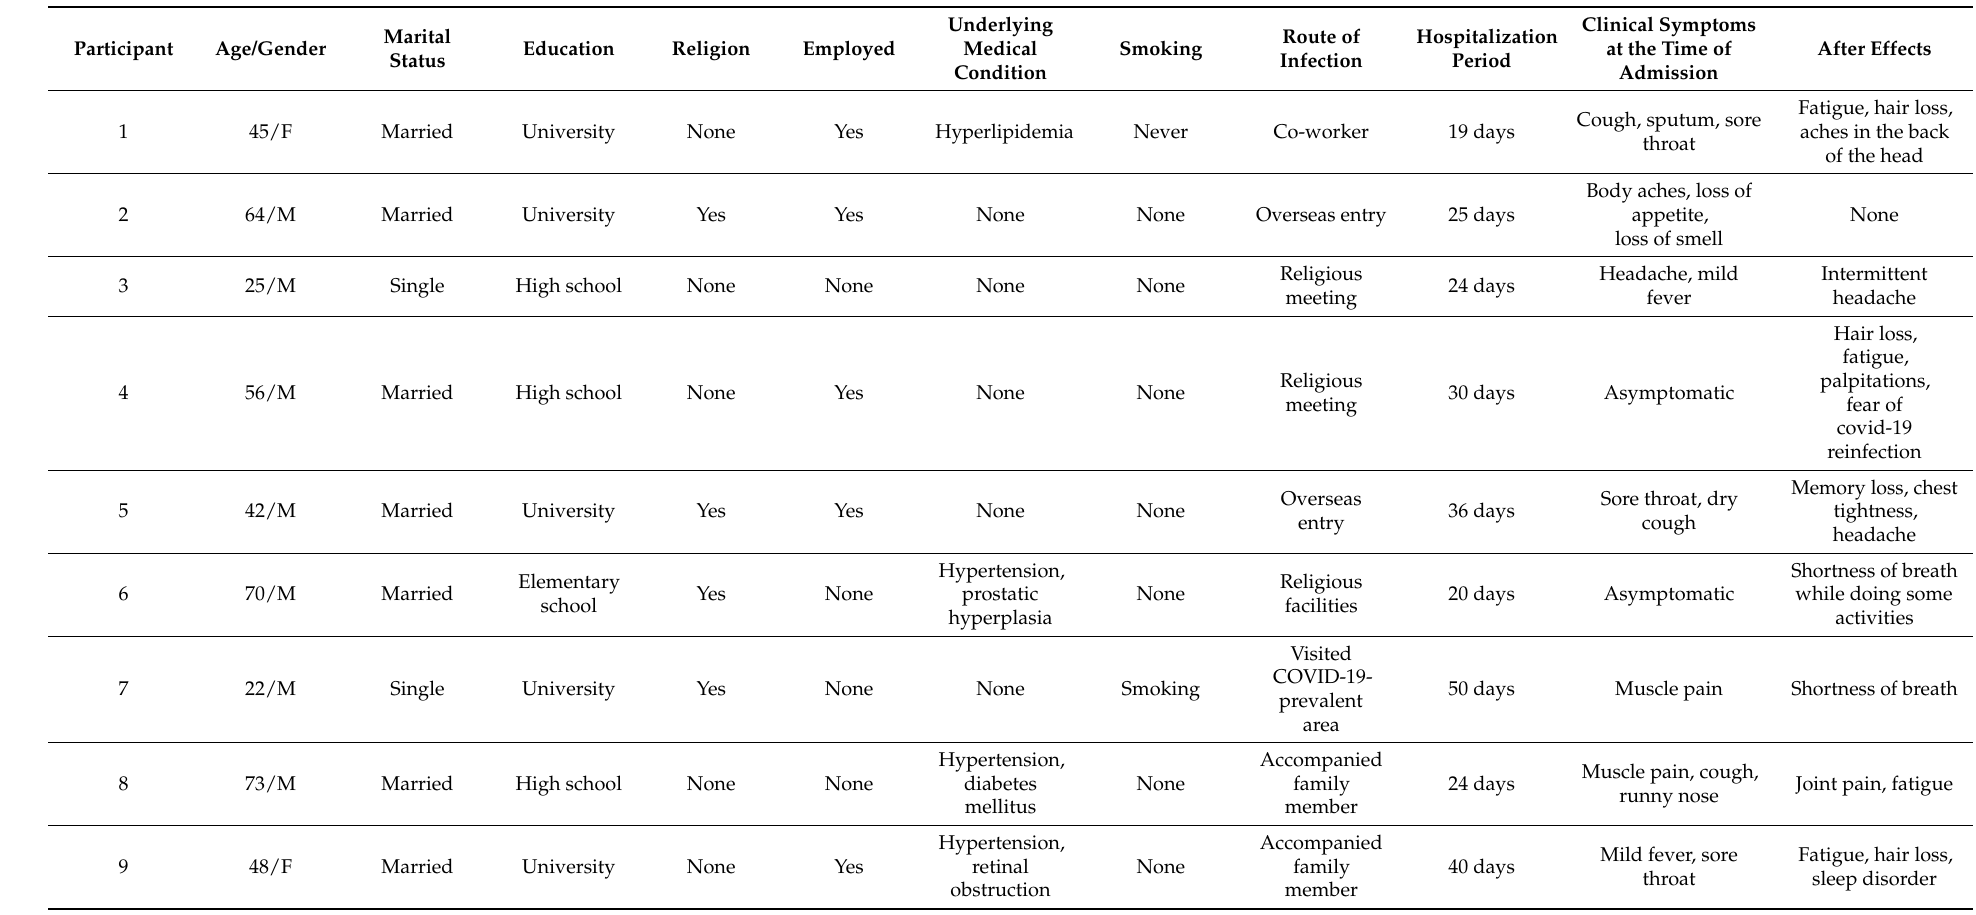
Table 1. Demographic and COVID-19-related data of